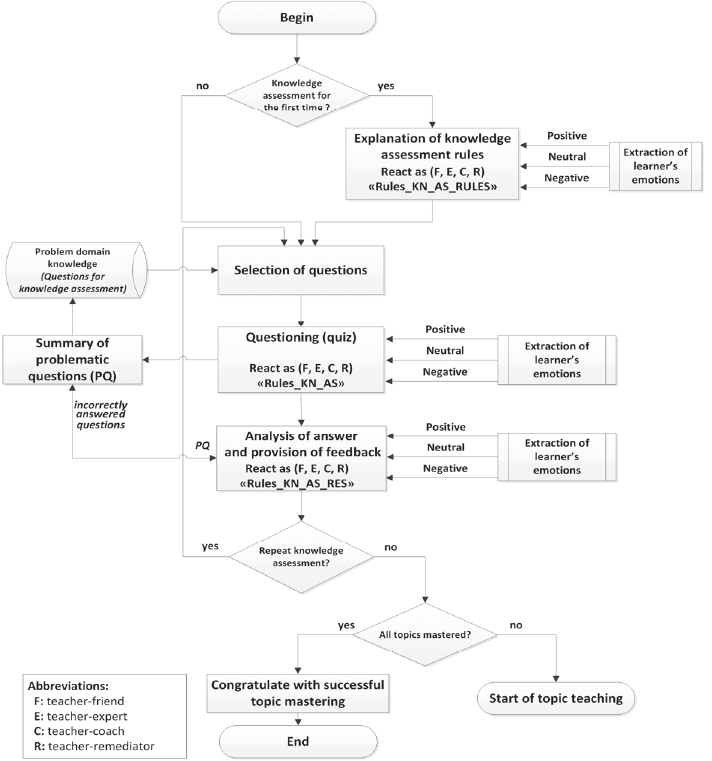
Fig. 2. Activities of knowledge